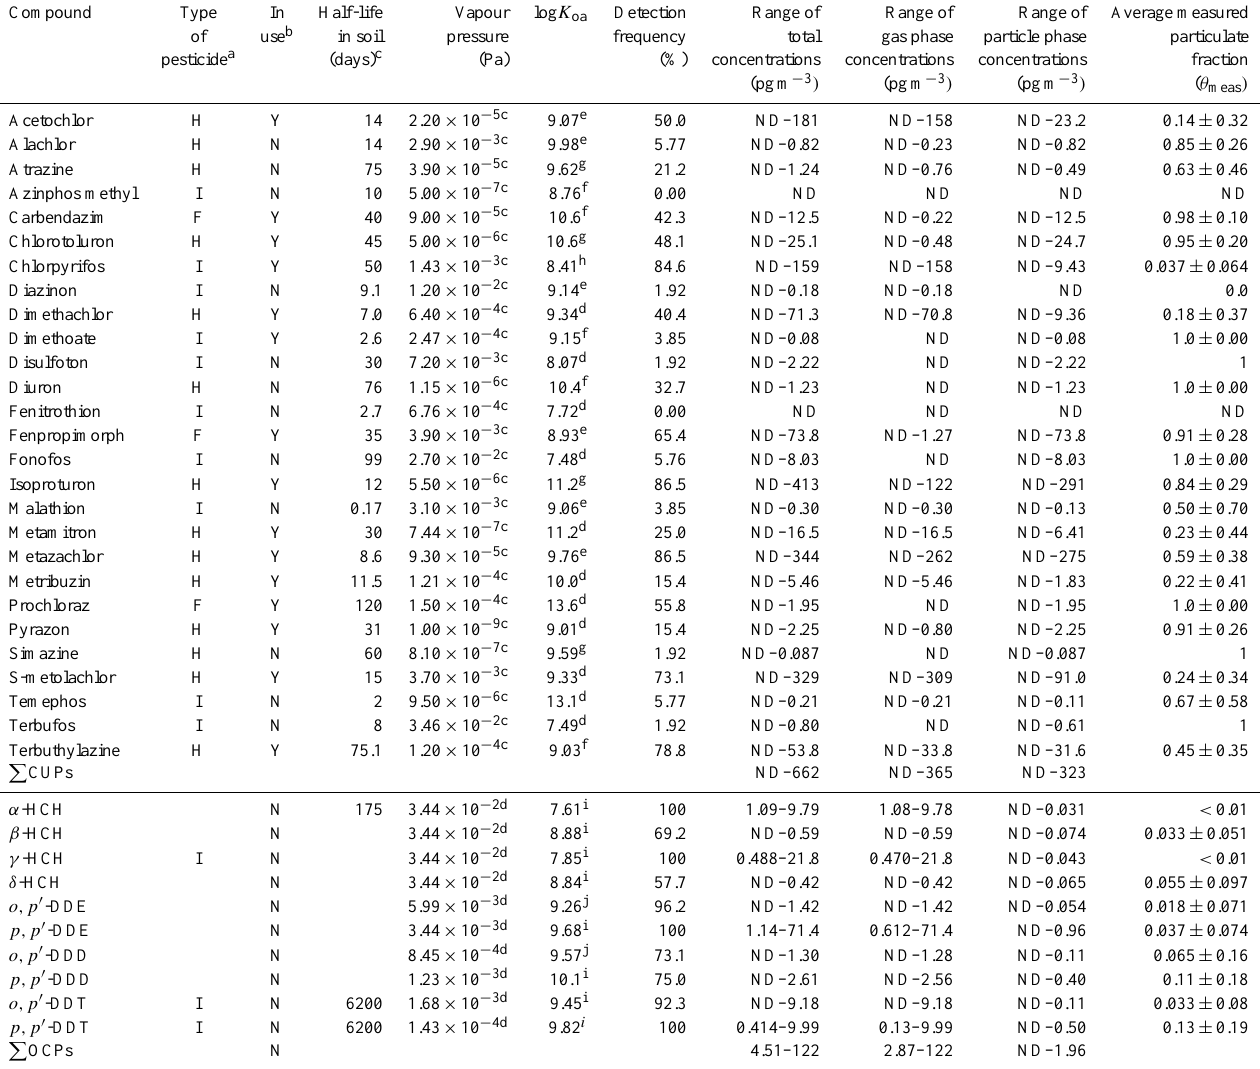
Table 1. Physicochemical properties and atmospheric concentrations (in pgm − 3 ) of individual OCPs and CUPs at background site. ND indicates “not